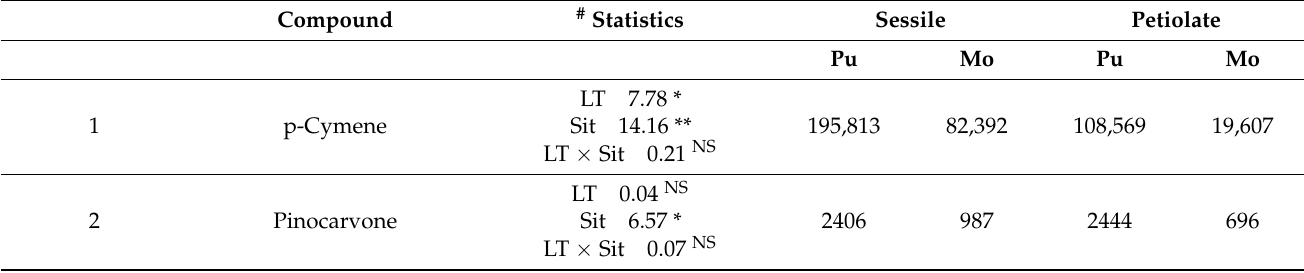
Table 5. Chemical characterization of volatile organic compounds in fresh sessile and petiolate leaves of two sites [Mosorrofa (Mo) and Puzzi (Pu)] of Salvia ceratophylloides